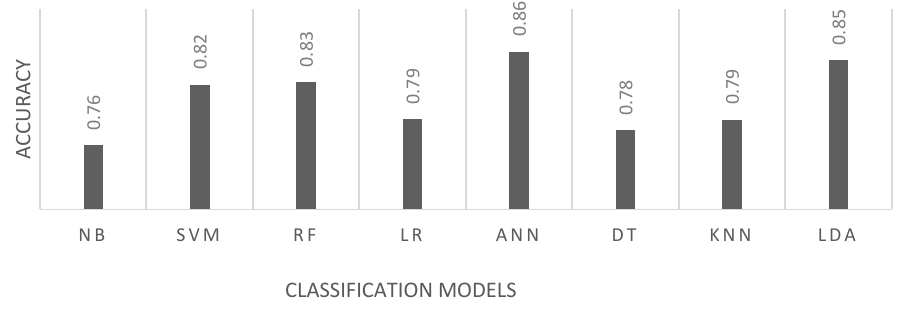
Figure 5. Mean accuracy by classification model.